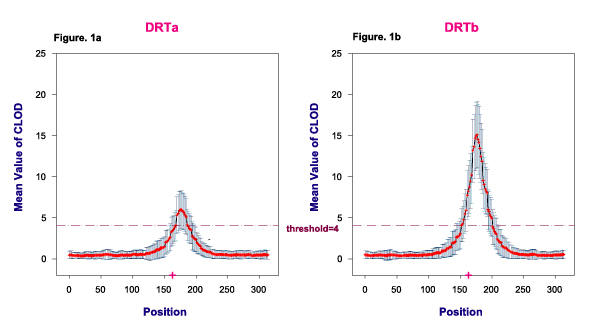
Mean value of CLOD for DRTa (a) and DRTb (b).